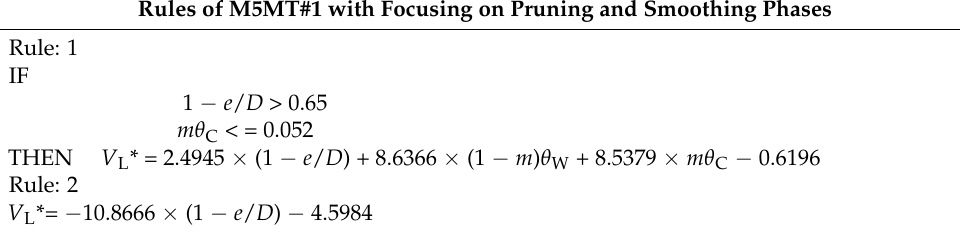
Table 10. Lists of M5MT details in V L * estimates. Rules of M5MT#1 with Focusing on Pruning and Smoothing